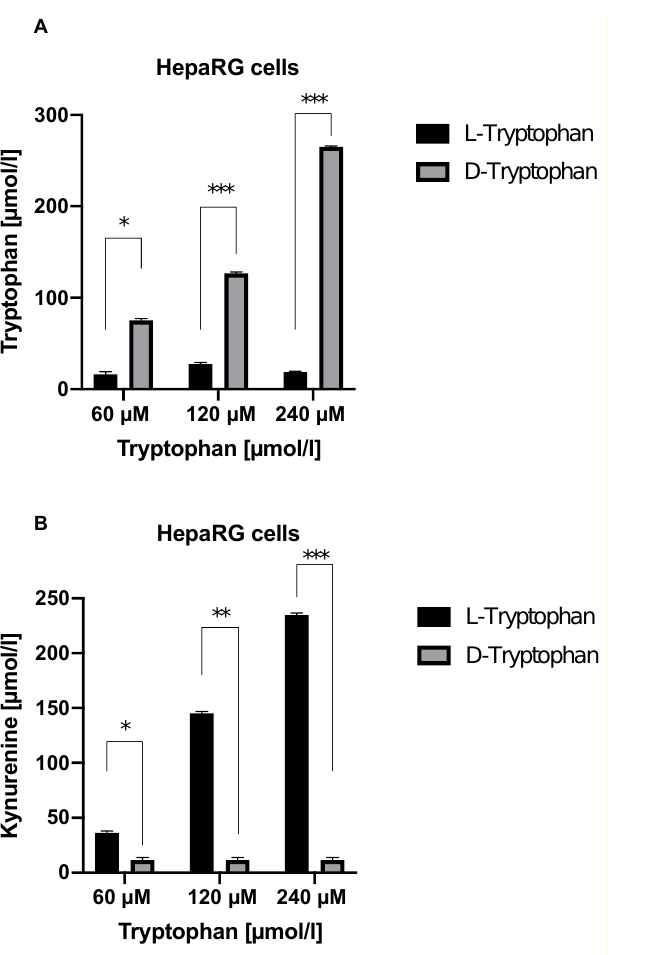
Figure 6. ( A ) Degradation of L-Trp and D-Trp by TDO in HepaRG cells. ( B ) Kyn accumulation from L-Trp and D-Trp degradation in HepaRG cells. * p < 0.05, ** p < 0.01, and *** p < 0.001.